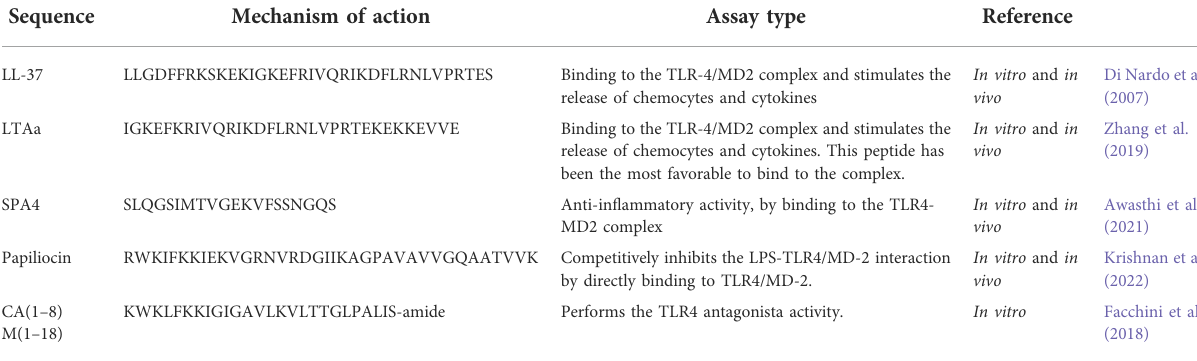
TABLE 1 Activity of antimicrobial peptides that act on the Toll Type 4